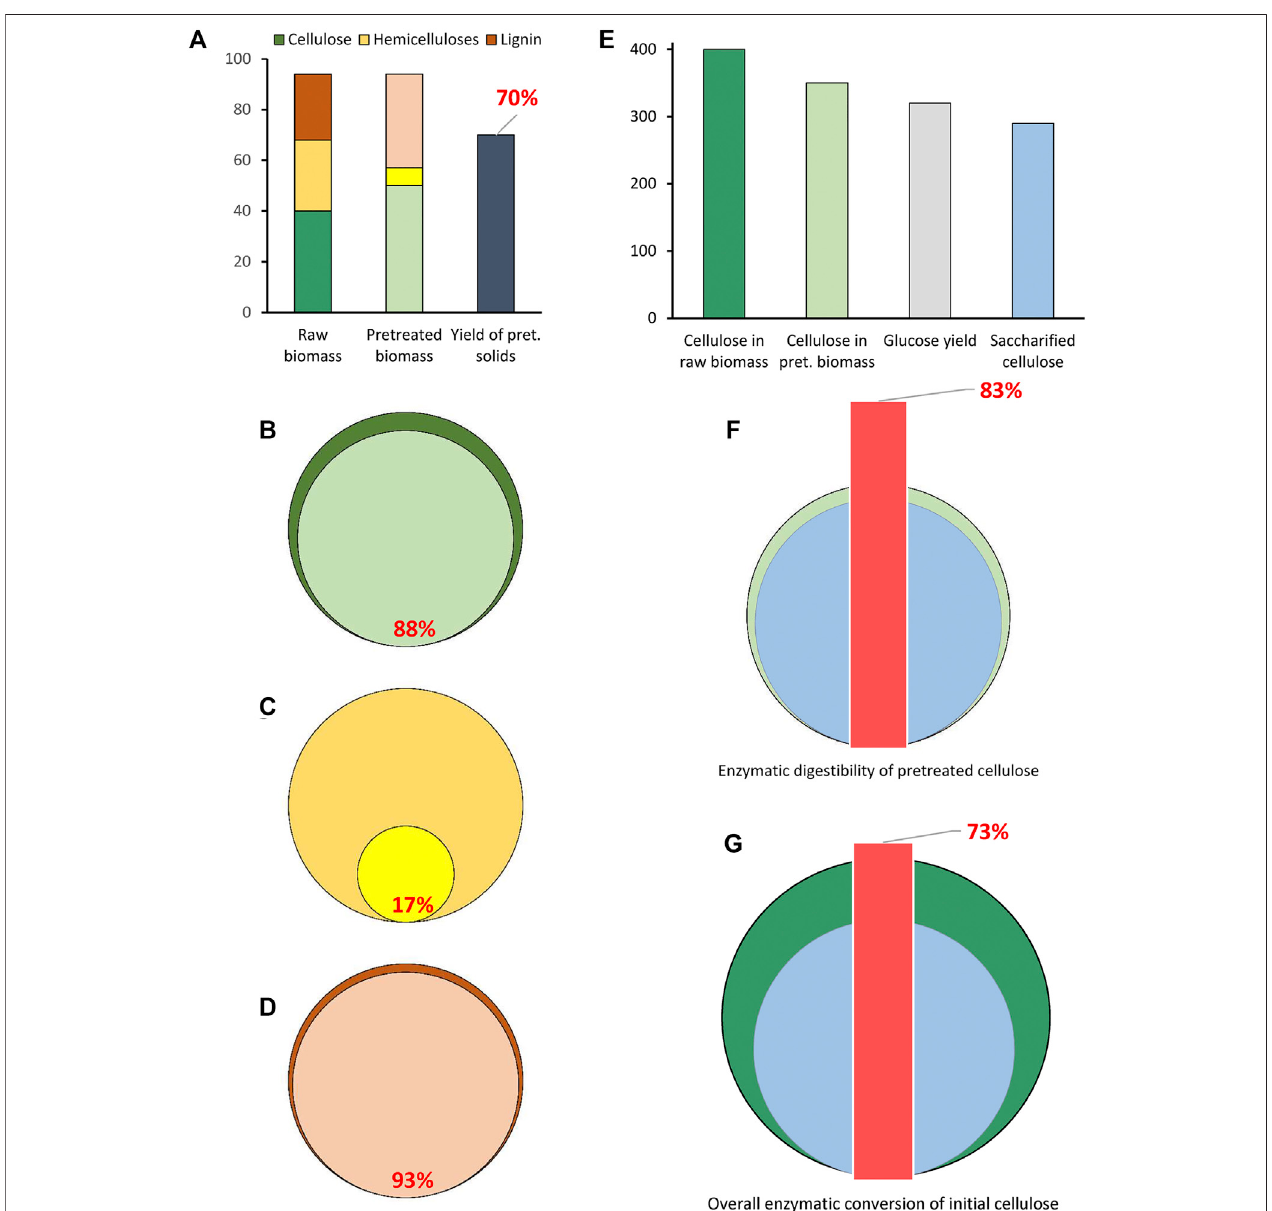
FIGURE 2 | Graphical representation of recovery of the main components in pretreated solids (A – D) and enzymatic sacchari fi cation indicators (E – G) . Input parameters (A) for recovery calculations (%) for cellulose (B) , hemicelluloses (C) , and lignin (D) in pretreated solid biomass. Input parameters (E) for calculation of enzymaticsacchari fi cationindicators(kg/toninitialbiomass); enzymaticdigestibilityofpretreatedcellulose(%) (F) ;overallenzymaticconversionofinitialcellulose(%) (G) . In (B) , (C) and (D) , internal circles represent the recovery of each component in pretreated biomass and external circles represent the initial amount (100%) of the component in raw biomass. In (F) and (G) , the internal circles represent sacchari fi ed cellulose, and the external ones represent cellulose in pretreated (F) or raw (G) biomass.